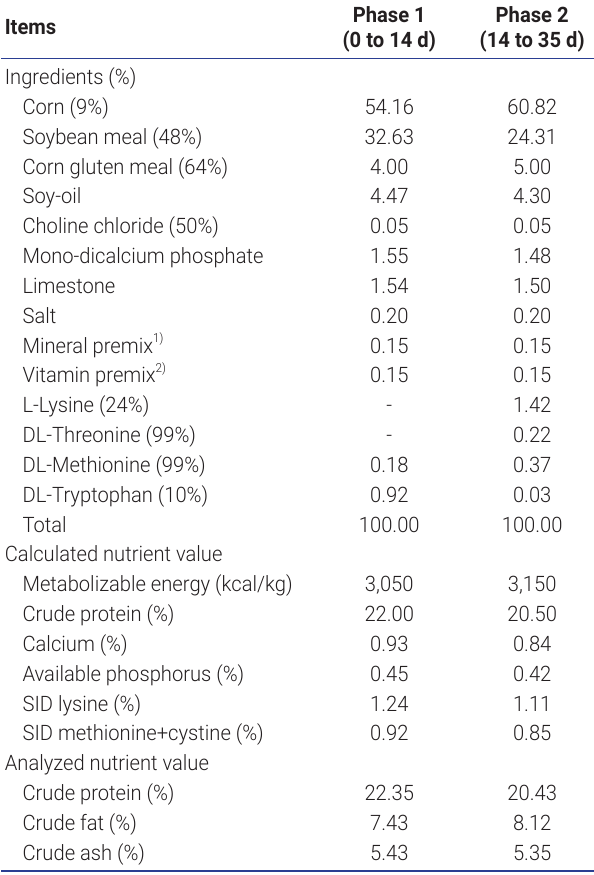
Table 1. Formula and chemical composition of experimental diets (as-fed basis) Items